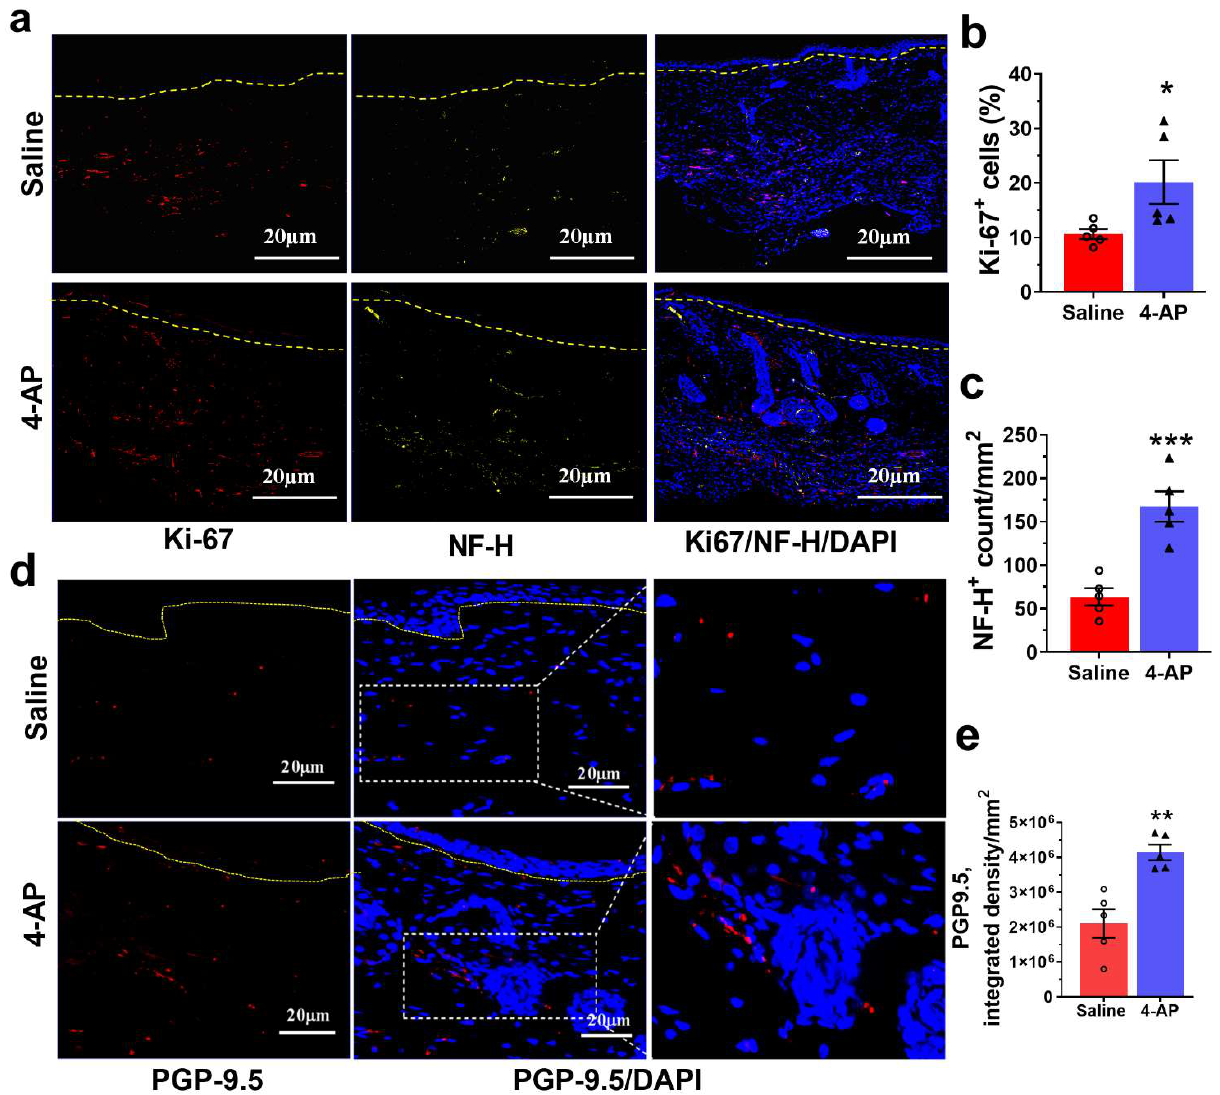
Figure 4. 4-AP promotes division reinnervation and enhanced PGP-9.5 expression. ( a ) Representative image of co-immunostaining for Ki-67 + cells (red) and NF-H + cells (yellow) surrounding de novo hair follicles in the healed wound at day 14 and dashed line denotes the epidermal/dermal border. Scale bars =20 μm. ( b , c ) Ki67 + and NF-H + cells were quantified. Data represents 20 images from 5 different mouse wounds and are shown as mean ± SEM, n = 5 animals per group, statistical significance indicated by asterisks (O = saline mouse data points, ∆ = 4-AP treated mouse data points,* = p between 0.01 and 0.05, and *** = p between 0.001 and 0.0002 vs. saline). ( d ) Representative images of PGP-9.5 protein expression by immunofluorescence staining of healed wounds. PGP-9.5 (red) and nuclear stain DAPI (blue) and the dashed line denotes the epidermal/dermal border. Scale bars = 20 μm. ( e ) Quantification (integrated density) of PGP-9.5 protein expression. Data represents 20 images from 5 different mouse wounds and are shown as mean ± SEM, n = 5 animals per group, statistical significance indicated by asterisks (O = saline mouse data points, ∆ = 4-AP treated mouse data points,** = p between 0.01 and 0.001 vs. saline).